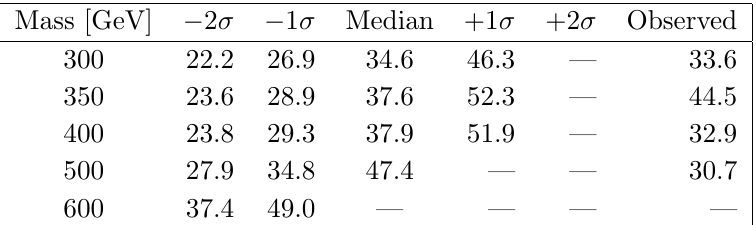
| | | Table 5 . Expected and observed 95% CL upper limits on tan (cid:12) as a function of m A in the light e t benchmark scenario. Since theoretical predictions for tan (cid:12) > 60 are not reliable, entries for which tan (cid:12) would exceed this value are indicated by